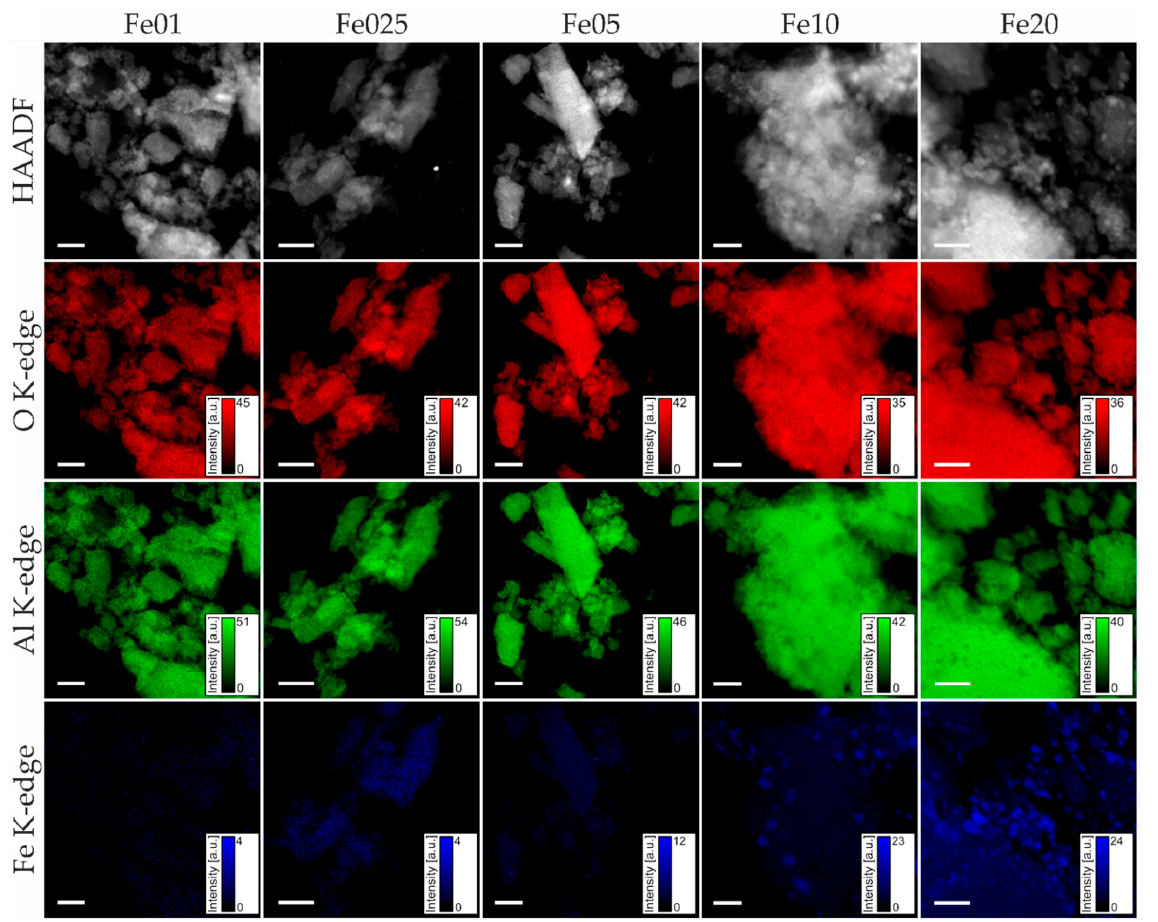
Figure 9. HAADF images (top row) and STEM-EDX images (red: oxygen K-edge signal; green: aluminum K-edge signal; blue: iron K-edge signal) of Fe01 to Fe20 (left to right); all scale bars 200 nm.